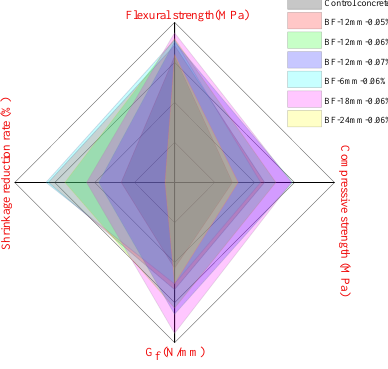
Figure 19. Strength, fracture energy and shrinkage reduction rate of control concrete and BFRCs.